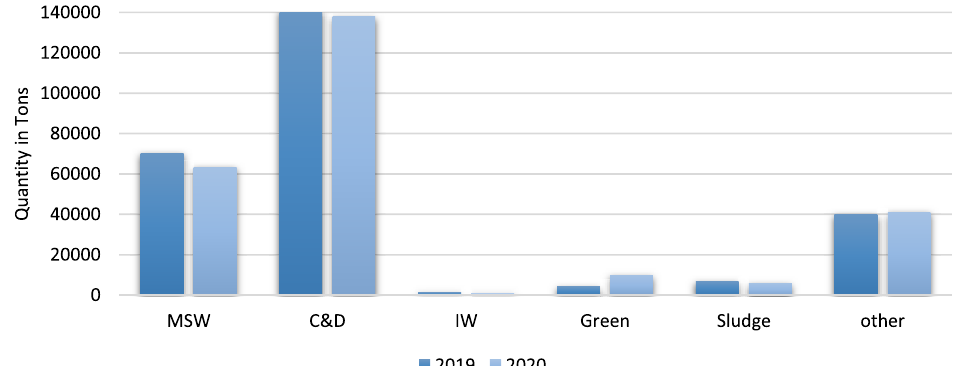
Fig. 6. Waste comparison 2nd quarter (2019 – 2020) (Ajman (cid:1) UAE)